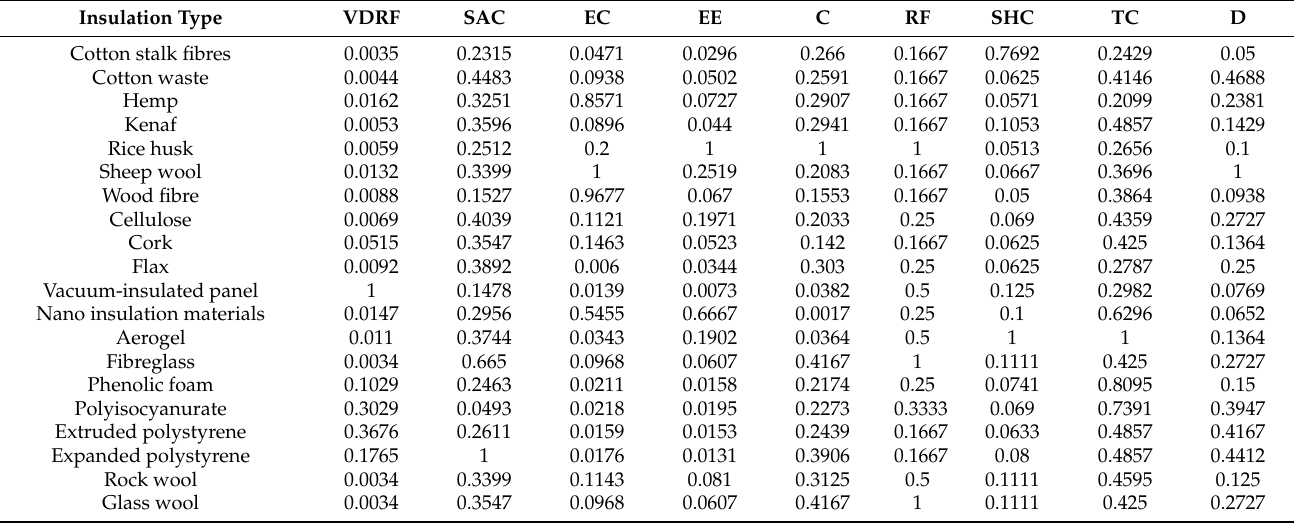
Table 7. The normalised matrix.